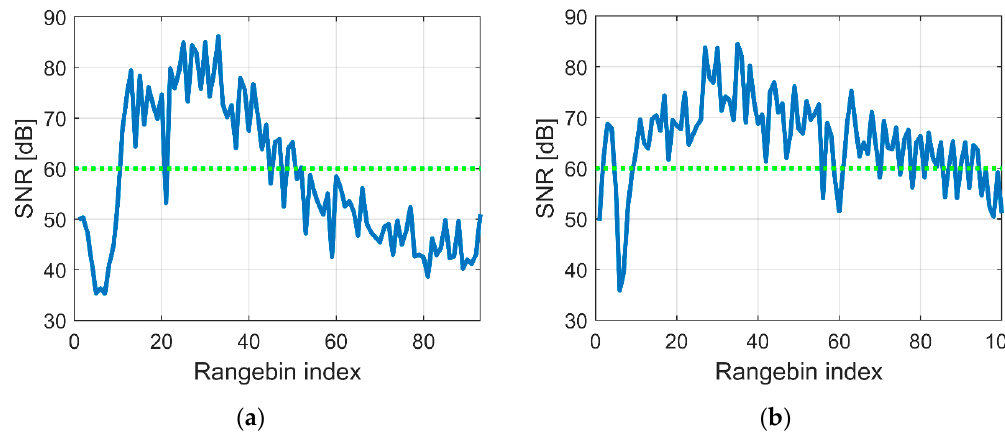
Figure 15. Significant maxims on the SNR profiles of the radars ( a ) R1 and ( b ) R2.